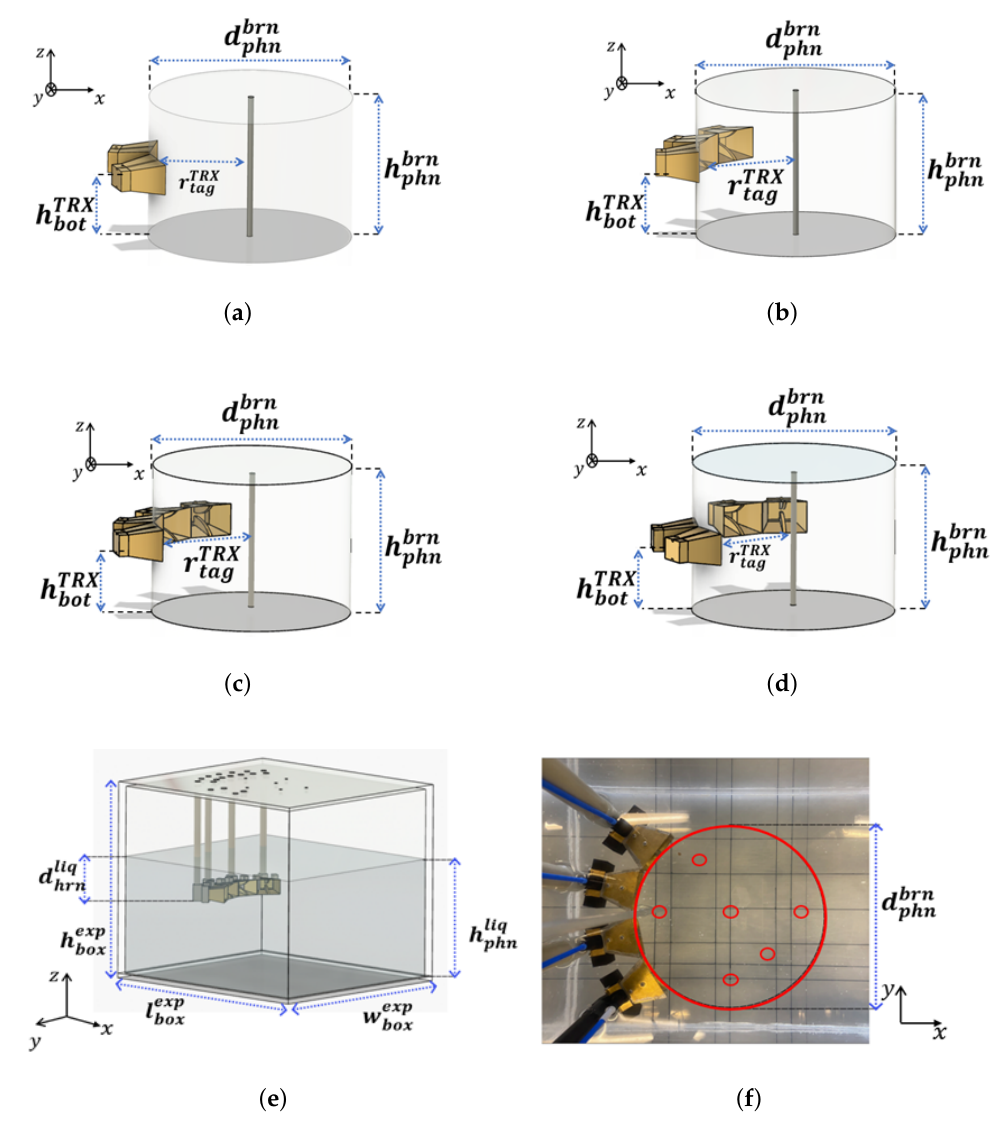
Figure 5. Simulated and measured setups. ( a ) Simulated system based on two UWB antennas. ( b ) Simulated system based on three UWB antennas. ( c ) Simulated system based on four UWB antennas. ( d ) Simulated system based on an orthogonal set of two UWB antennas. ( e ) 3D illustration of the measured setup. ( f ) Top view of the measurement